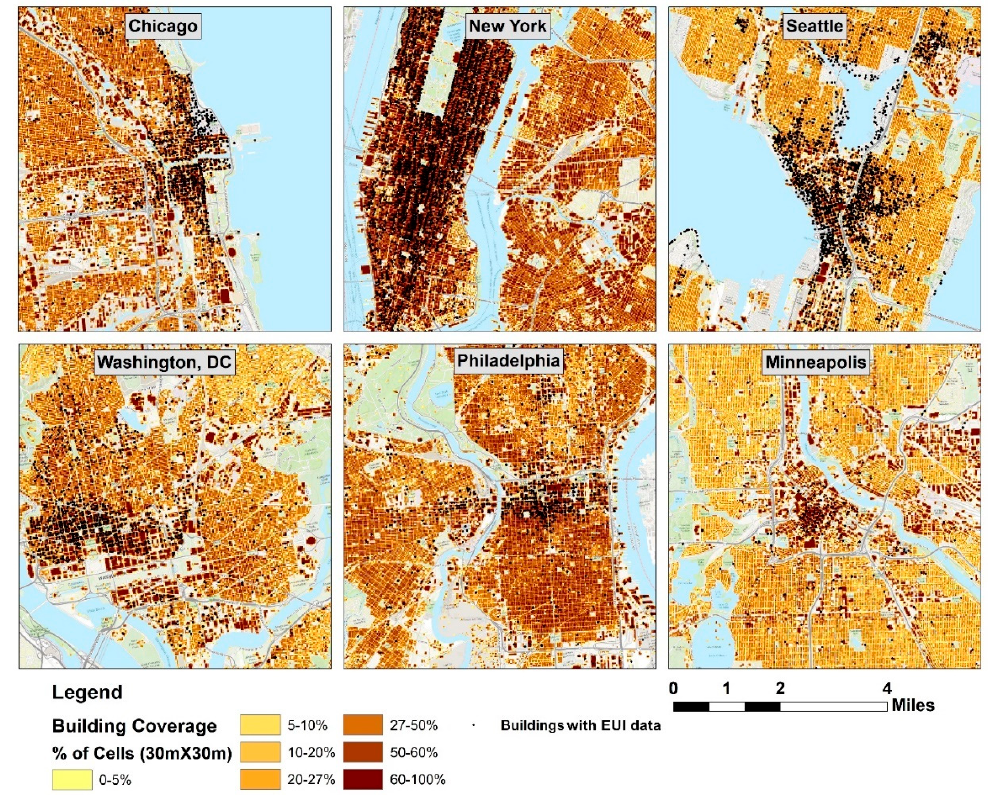
Figure 1. Building footprint coverage in 30×30 m 2 cells.